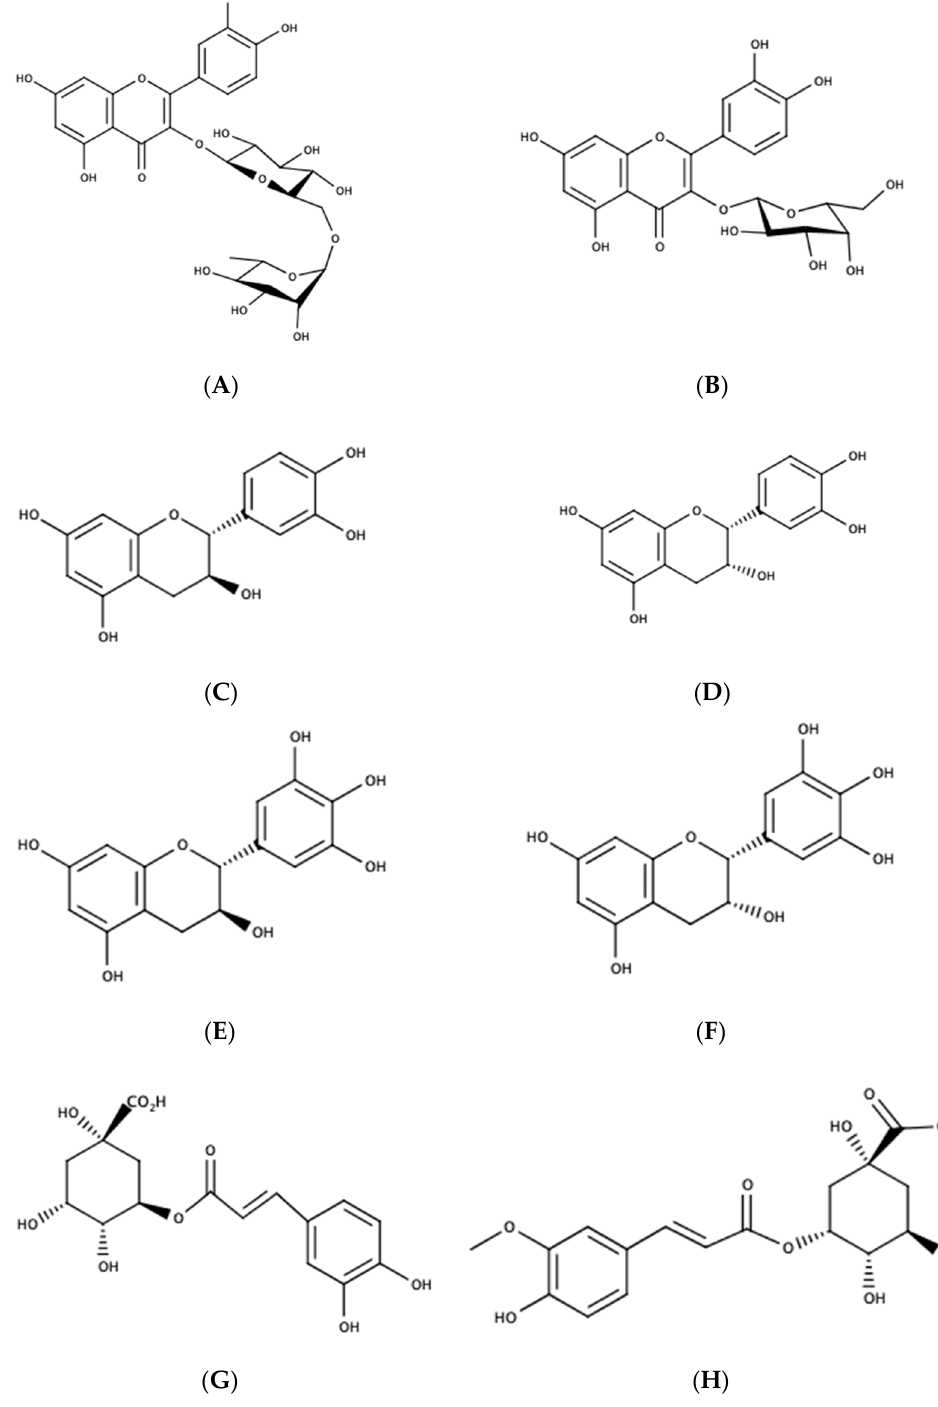
Figure 2. Chemical formulas of the main polyphenols found in bilberry leaves; ( A )—Quercetin 3-O-rutinoside; ( B )—Quercetin 3-O-galactoside; ( C )—Catechin; ( D )—epicatechin; ( E )—gallocatechin; ( F )—epigallocatechin; ( G )—Chlorogenic acid; ( H )—Feruloyquinic acid. Proanthocyanidins are classified according to the monomeric units in 13 classes, but procyanidins, prodelphinidins and pelargonidins are frequently encountered. Proantho- cyanidins with a degree of polymerization between 2–4 are considered oligomers, and those with a degree of polymerization greater than 4 are considered polymers, but this classification is still under debate [40,41]. As shown in Table 5, the proanthocyanidins found in V. myrtillus leaves are mainly B-type dimers and trimers procyanidins. These compounds are cleaved through acid hydrolysis into flavan-3-ols. Anthocyanins are not a class of compounds that are usually found in bilberry leaves. However, depending on the sun exposure, small quantities of anthocyanins have been detected in bilberry leaves due to a complex regulatory mechanism, influenced by high solar radiation [42]. As well, the presence of anthocyanins could be related to the extrac- tion method, which could have released the anthocyanins from procyanidins. Table 6. Triterpenes and phytosterols identified in bilberry leaves. Compound